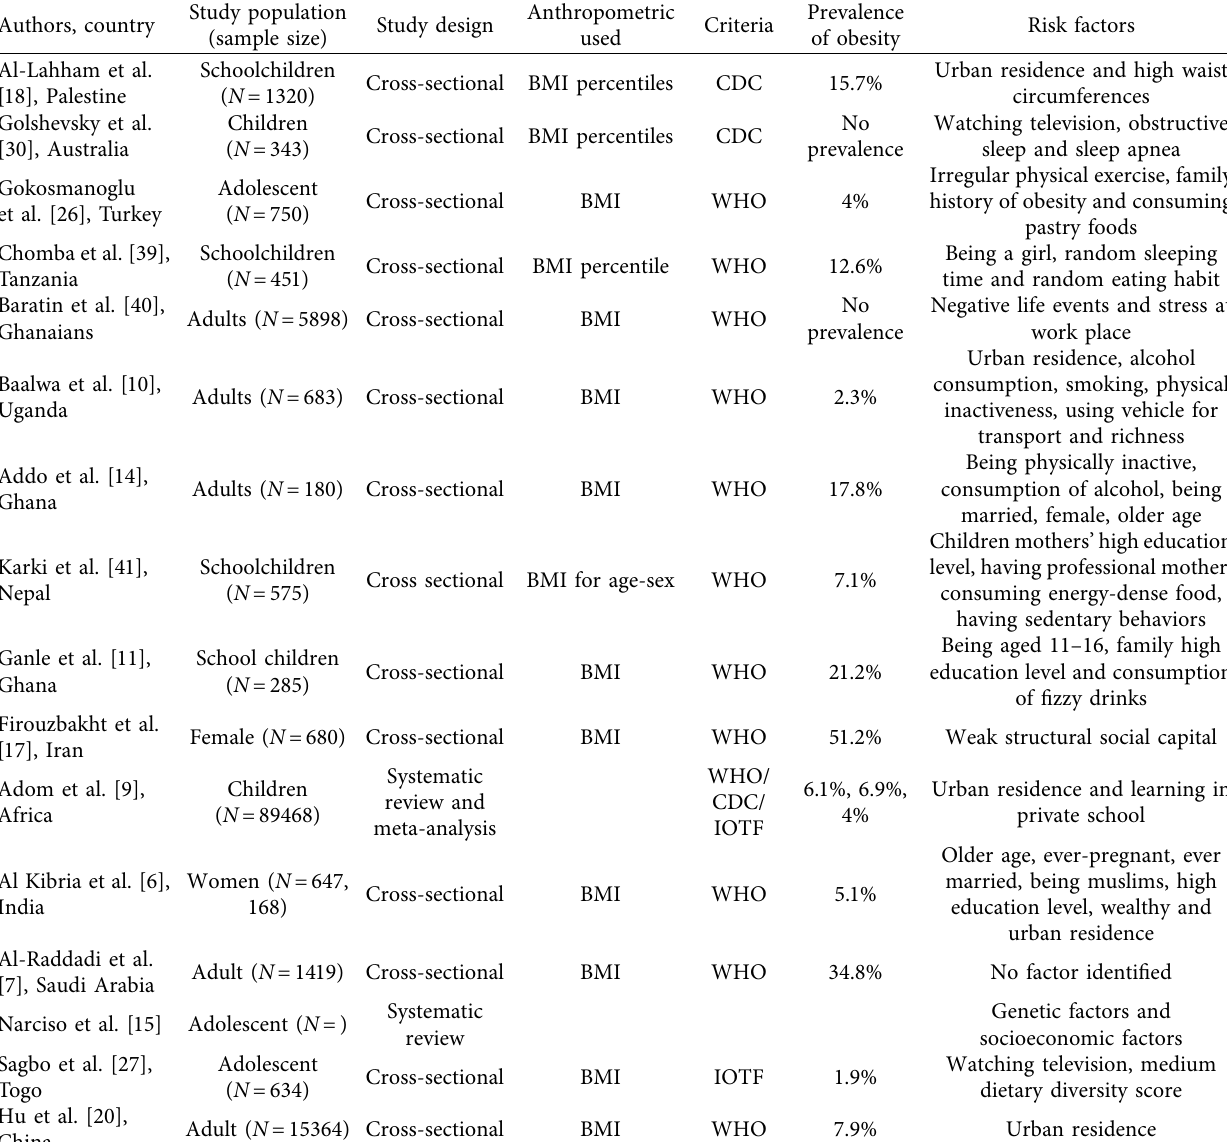
Table 1: Descriptive characteristics of studies included in this